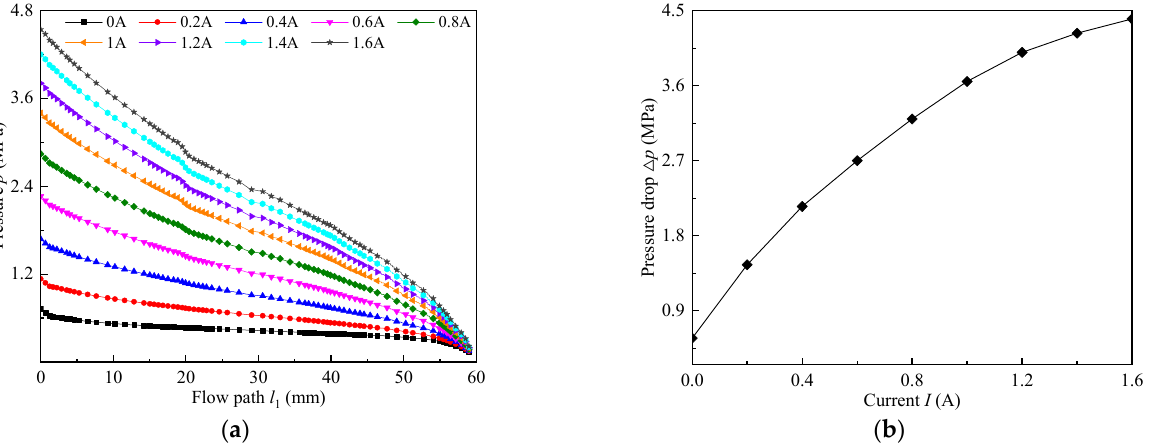
Figure 4. Pressure distribution in the damping channel under different currents: ( a ) pressure varies with flow path, ( b ) pressure drop varies with current.